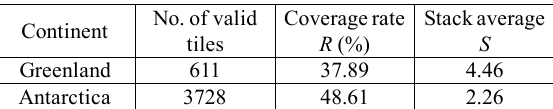
Table 2.The R and S for tiles in Greenland and Antarctica.